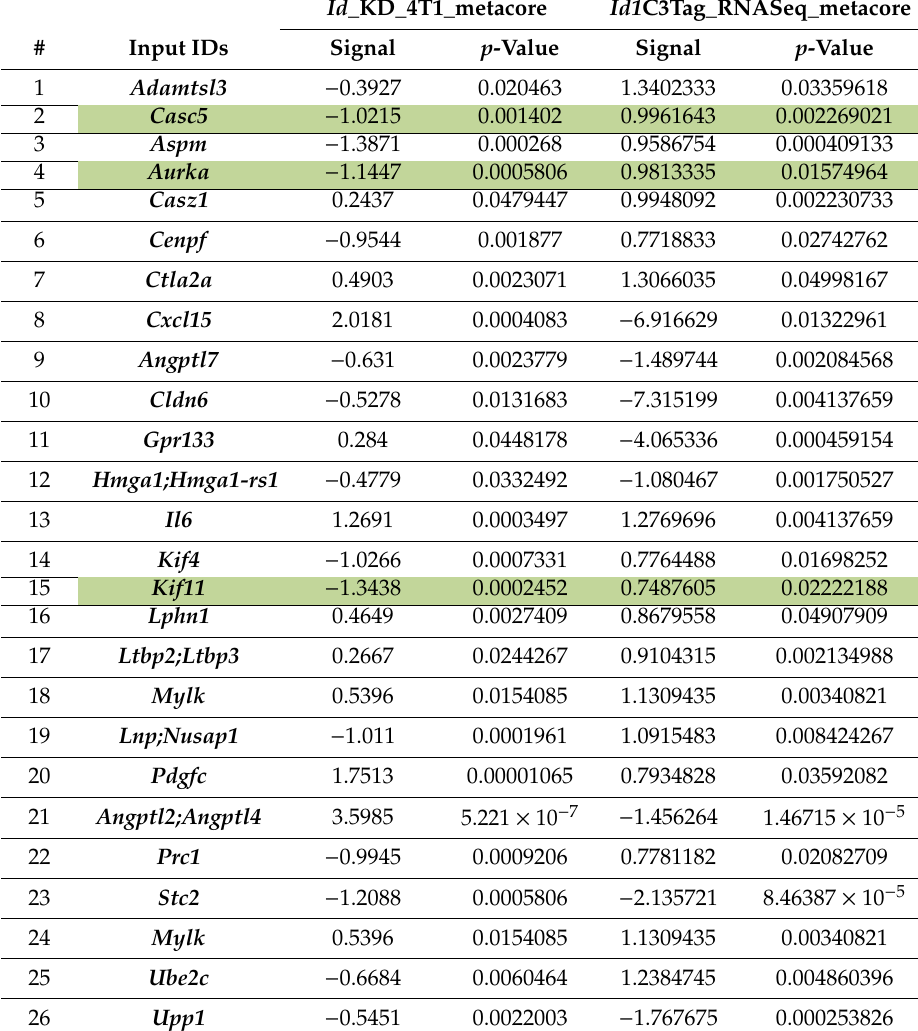
Table 1. List of di ff erentially expressed genes common to Id1 expression and Id -depleted model system. The genes highlighted in green were used in further analysis as putative Id